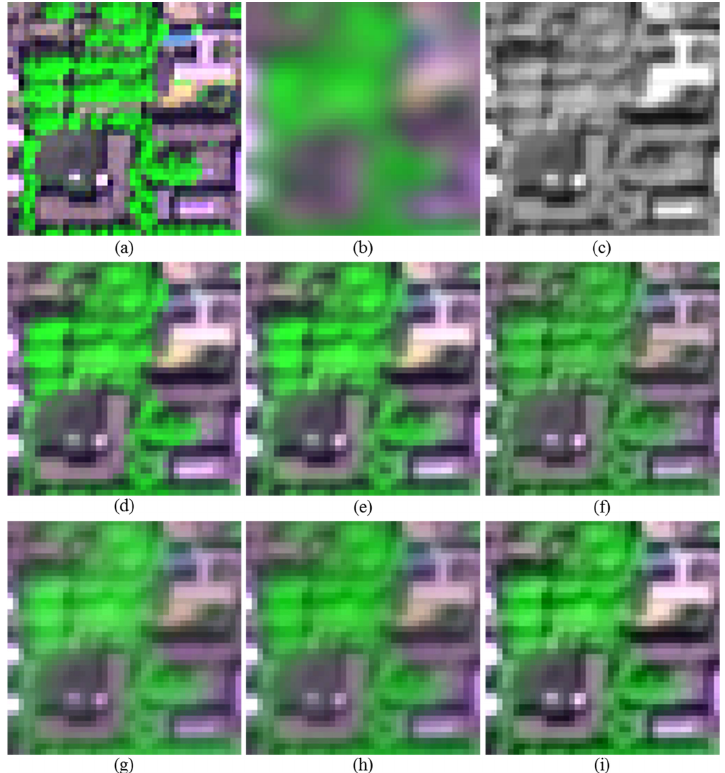
Figure 7. The 64 × 64 pixel subsets of the MS images and the corresponding fused images produced from the degraded IKONOS dataset: ( a ) true 4-m MS image; ( b ) up-sampled version of the 16-m MS image; ( c ) 4-m PAN image; and the results of ( d ) UHR fusion; ( e ) HR fusion; ( f ) PS fusion; ( g ) GS1 fusion; ( h ) GS2 fusion and ( i ) GSA fusion.